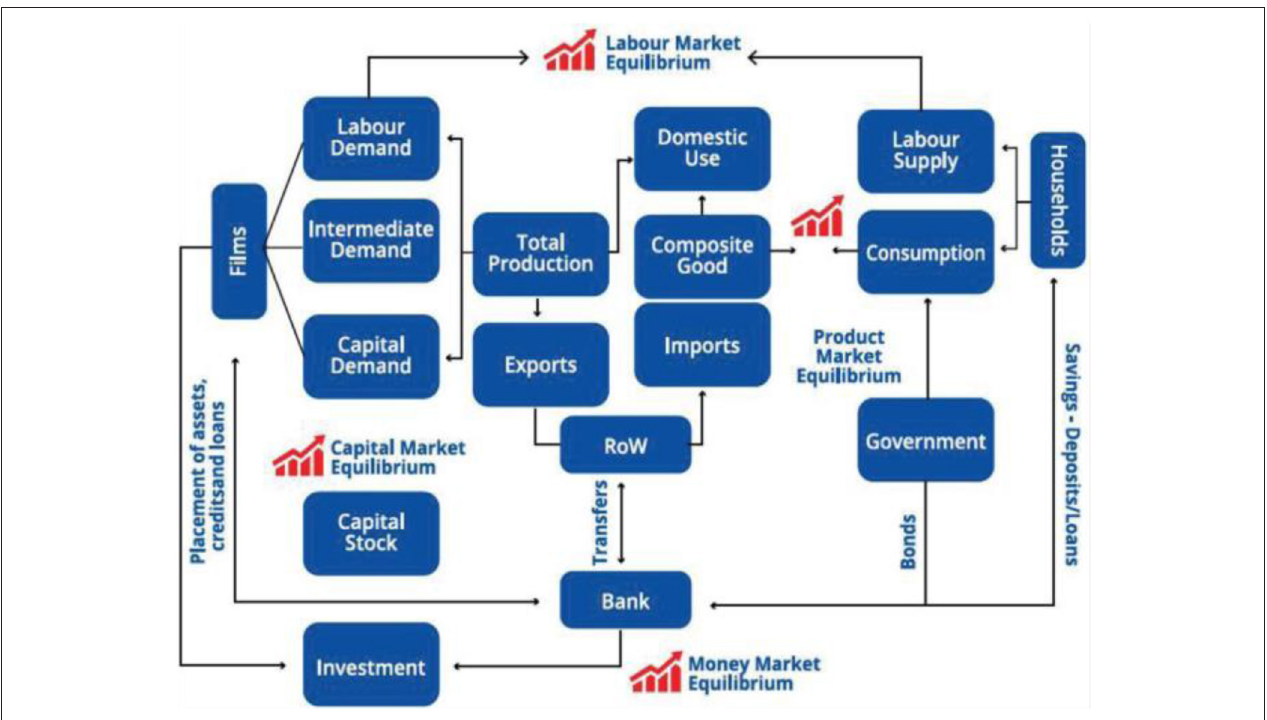
FIGURE 1 | GEM-E3-FIT